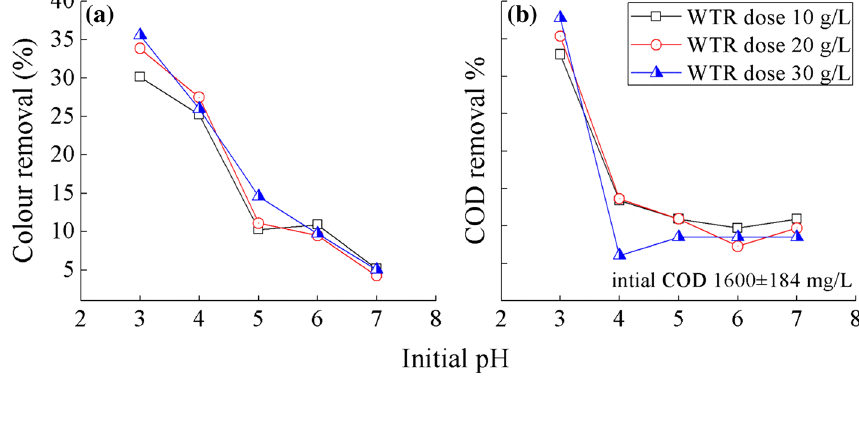
Fig. 7 Breakthrough curve for colour removal at a initial pH 6.2, b initial pH 3.0